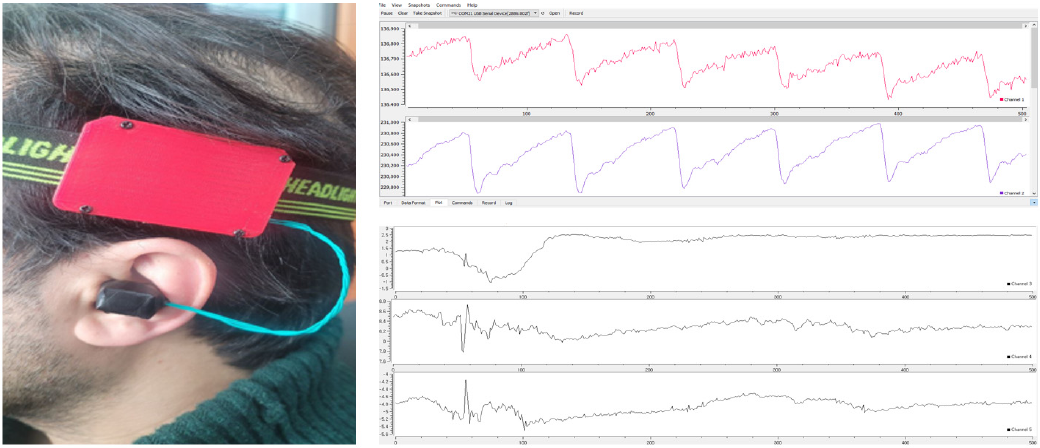
Figure 3. In − ear PPG setup, showing simultaneous recordings of PPG and tri − axis acceleration sig- Figure 3. In-ear PPG setup, showing simultaneous recordings of PPG and tri-axis acceleration signals, nals, with accompanying data acquisition software. with accompanying data acquisition